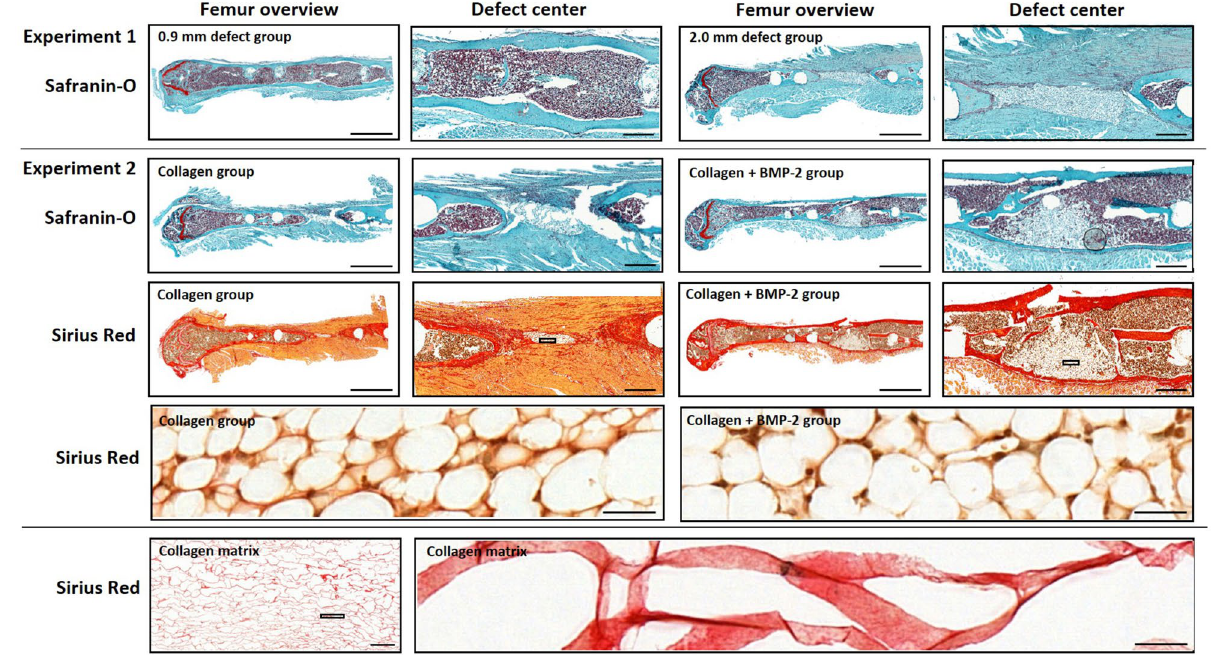
Figure 5. Histology of longitudinal sections of fractured femora 6 weeks after defect surgery. Row 1: Safranin-O staining of 0.9 mm and 2.0 mm defect groups—overview images, scale bar = 1 mm and area between inner pins of fixator, scale bar = 100 µm. Row 2: Safranin-O staining of collagen and collagen + BMP-2 groups— overview images, scale bar = 1 mm and area between inner pins of fixator, scale bar = 100 µm. Row 3: Sirius- Red staining of collagen and collagen + BMP-2 groups—overview images, scale bar = 1 mm and area centered between inner pins of fixator, scale bar = 100 µm. Row 4: Sirius-Red staining of defect center of collagen group and collagen + BMP-2 group, scale bar = 50 µm. Row 5: Sirius-Red staining of original collagen matrix, scale bar = 500 µm (left image) and 50 µm (right